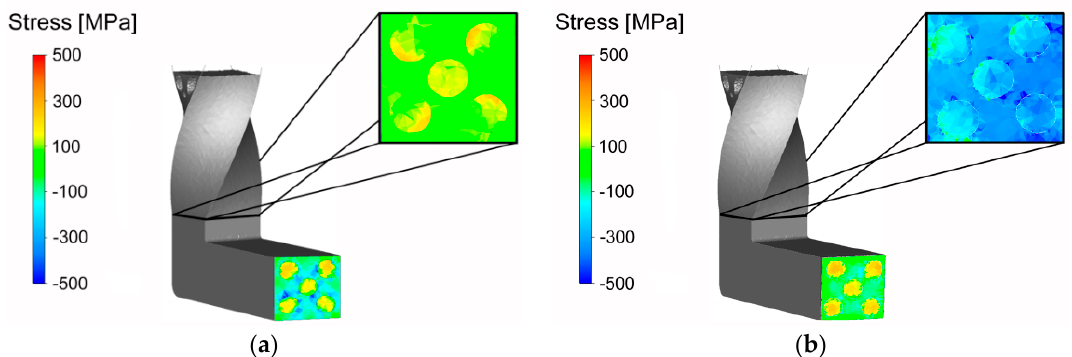
Figure 8. Distribution of residual stress during: first pass ( a ); second pass ( b ).